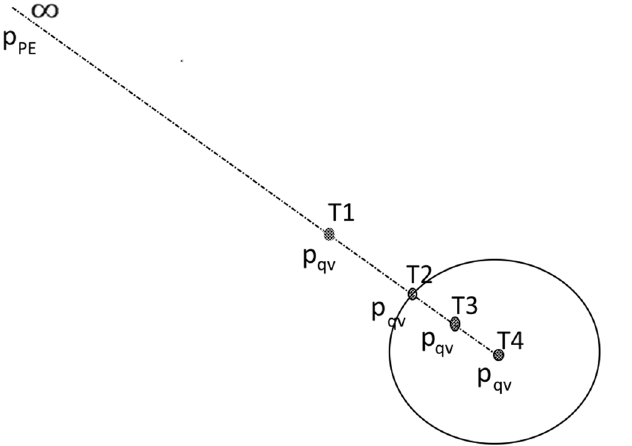
Figure 5. Gravitational potential and variable density of the vacuum.